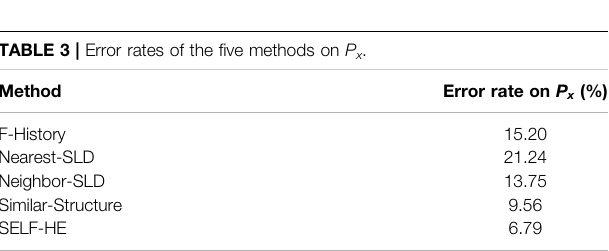
TABLE 3 | Error rates of the fi ve methods on P x